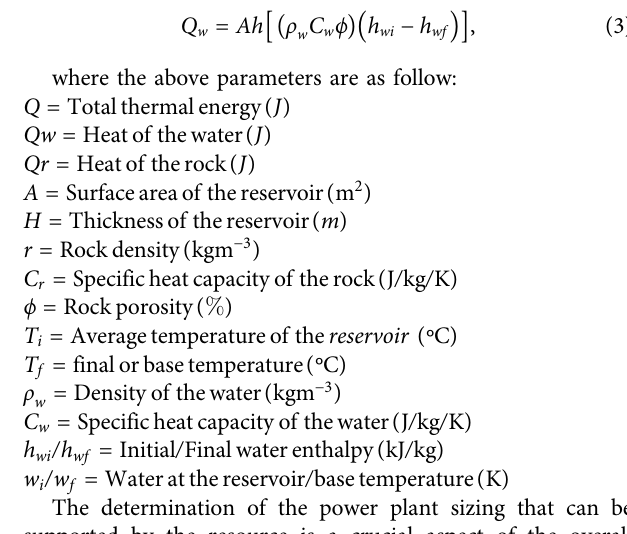
Frontiers in Energy Research |